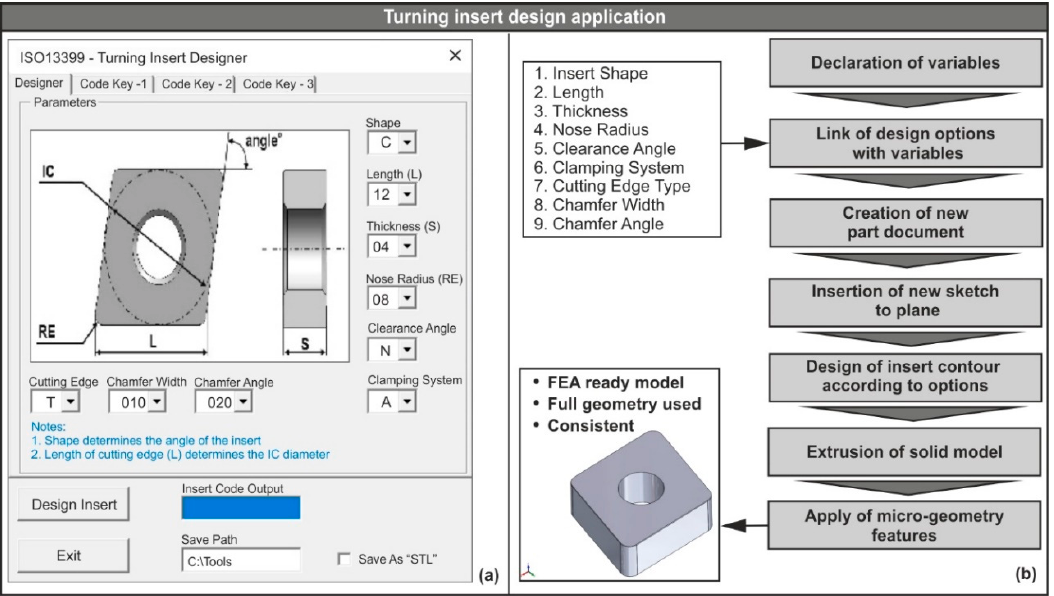
Figure 1. ( a ) The graphical interface of the designer application and ( b ) its workflow.